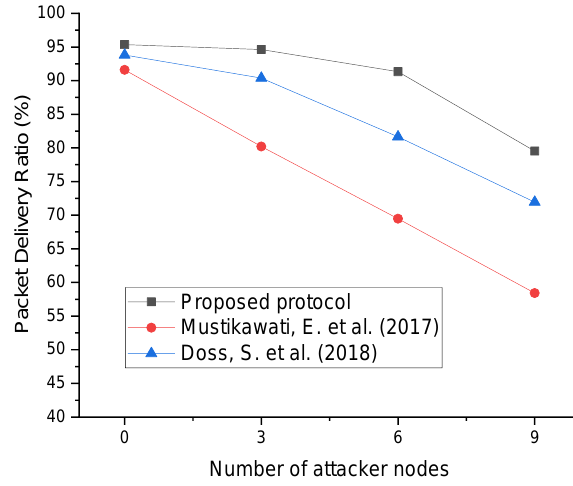
Figure 13. Packet delivery ratio under Jellyfish delay variance attacks [20,37].